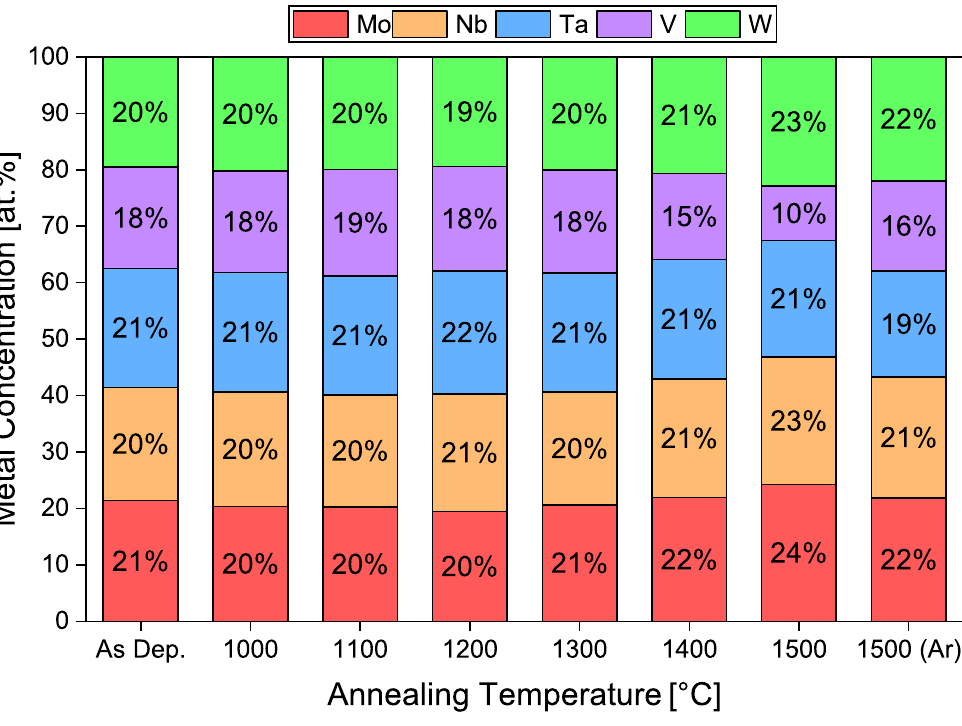
Figure 2. Chemical composition of MoNbTaVW thin films on Al 2 O 3 substrates in as-deposited state and after annealing in vacuum and in Ar